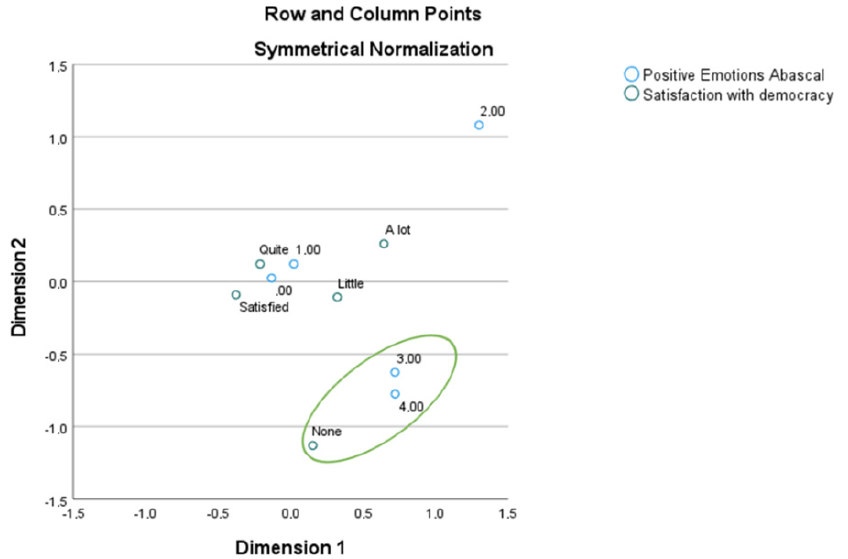
Figure 2. Correspondence analysis of the level of satisfaction with democracy in relation to positive emotions towards Santiago Abascal. Source: authors’ own creation based on the data of the post- electoral study of the November 2019 general election conducted by Political Research